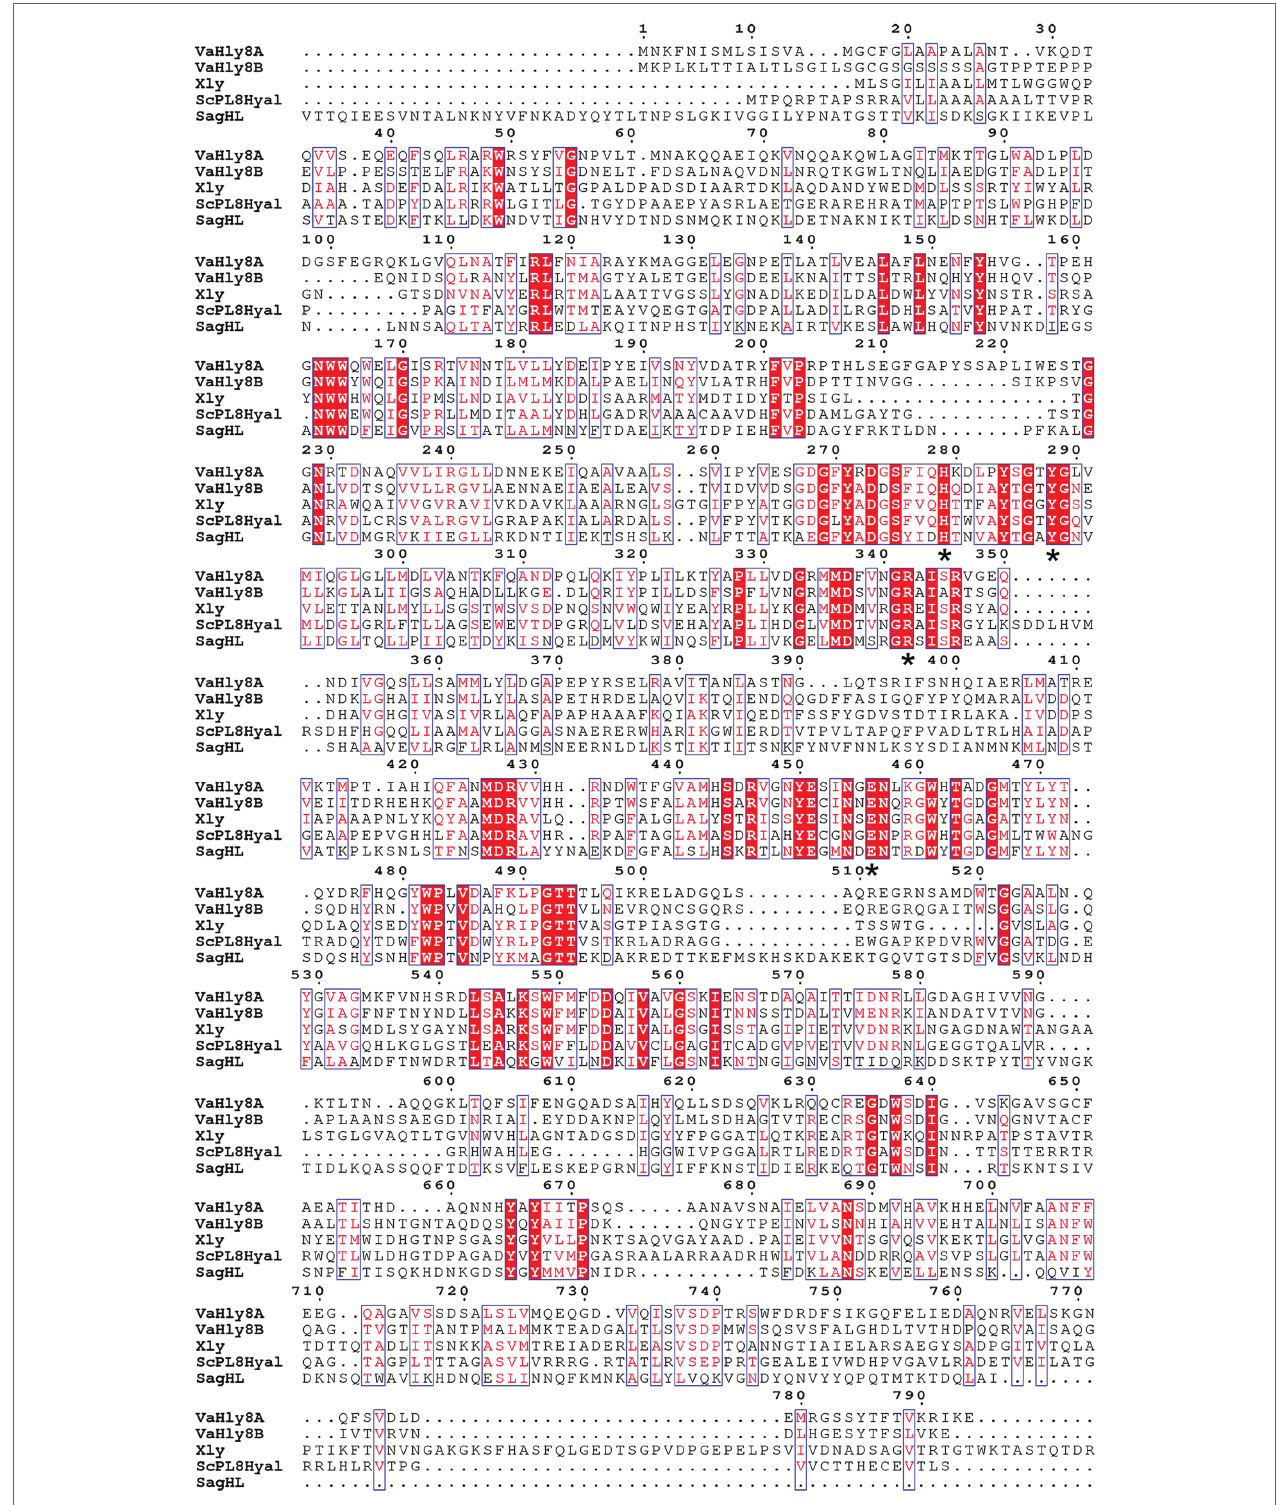
FIGURE 3 | Protein sequence alignment of VaHly8A and VaHly8B to the identified enzymes of the PL8 family. Red background represents the same amino acid residues and blue frames indicate amino acid residues with identity > 70%. The critical catalytic residues were highlighted by asterisks below them. Xly, from Bacillus sp. GL1, Genbank: BAB21059.1; ScPL8Hyl, from Streptomyces coelicolor A3(2), Genbank: CAA19982.1; SagHL, from Streptococcus agalactiae NEM316, Genbank: